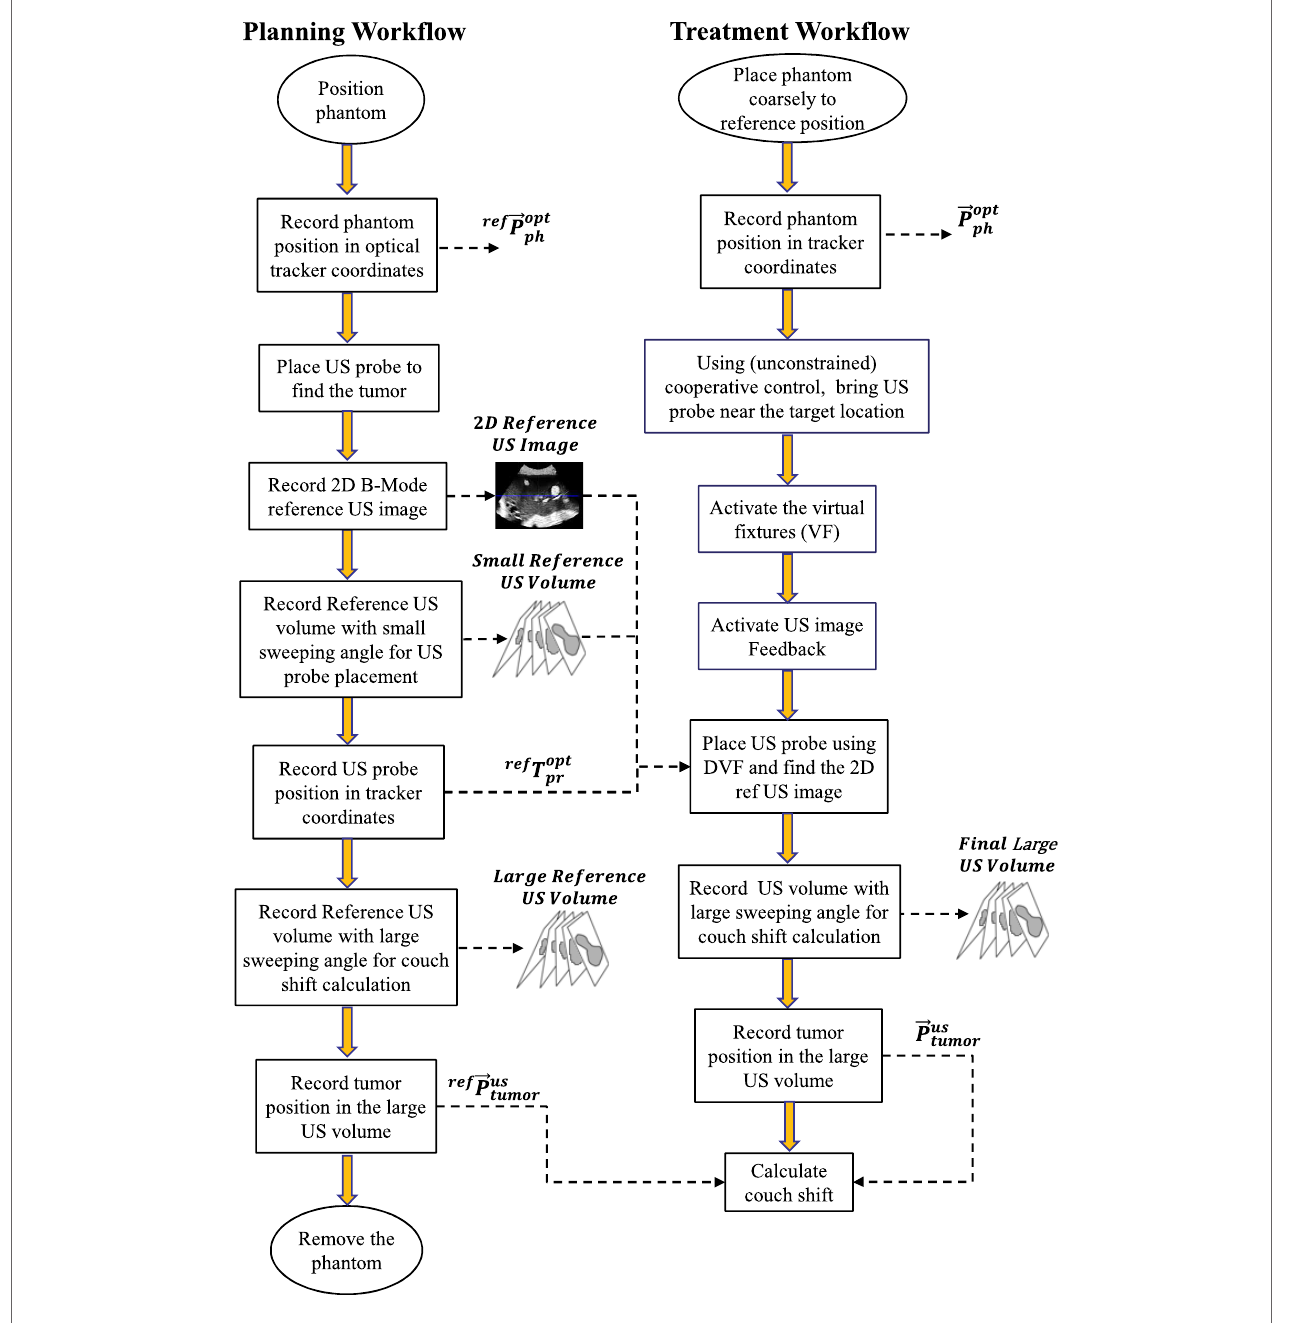
FIGURE 7 | Experiment workflow for testing US image-based patient setup .